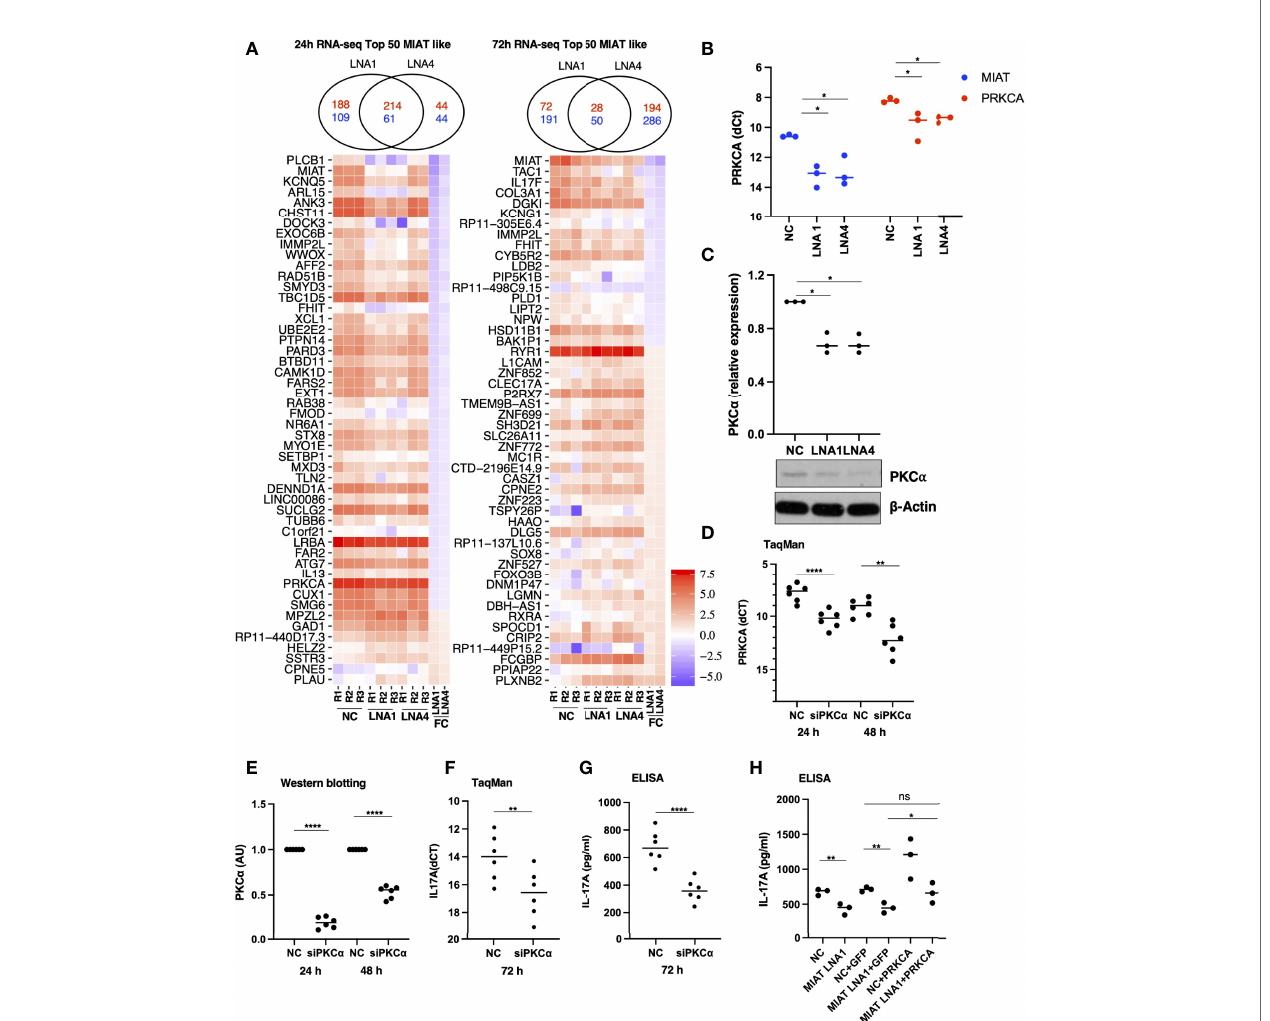
FIGURE 4 | RNA-seq Analysis Identi fi ed MIAT Targets in Human Th17 Cells. (A) Venn diagrams on the top show the overlap of the number of differentially regulated genes (FDR <0.05 and LFC >1.5) when comparing LNA1- or LNA4-transfected samples to the negative control LNA (NC). The numbers in red indicate common and unique upregulated genes, and numbers in blue indicate common and unique downregulated genes upon MIAT silencing. Heatmap representation of the expression of the top 50 DE genes similarly regulated (see results section for details) upon MIAT silencing at 24 (left) and 72 h (right) in Th17 cells. NC, LNA1 and LNA4 columns represent the gene expression (RPKM) in respective samples. FC columns represent the fold-change in gene expression upon MIAT silencing. (B) TaqMan qPCR of PRKCA expression analysis in MIAT silenced Th17 cells with two different LNAs at 24 h, where each dot represents an independent experiment. Students ’ paired two-tailed t-test was used to determine the signi fi cance. *, p <0.05. (C) Western blot expression analysis of PKC a proteins in MIAT-silenced 24-h Th17 cells. A representative result (lower panel) from three independent experiments for PKC a is shown along with b -actin for loading control. WB quanti fi cation was performed using ImageJ, from three independent experiments (upper panel), and signi fi cance was calculated using Students ’ t-test (two-tailed, paired). *, p <0.01. The data were plotted as arbitrary units (AU). (A-C) The experiments were performed on three pools of CD4 + T cells, where each pool contained cells puri fi ed from umbilical cord blood collected from 3-5 individuals. (D) TaqMan qPCR of PRKCA expression analysis showing knockdown ef fi ciency of the siRNA at RNA level at 24 h and 72 h. Students ’ paired two-tailed t-test was used to determine the signi fi cance. **, p <0.01; ****, p <0.0001. (E) Western blot expression analysis of PKC a proteins showing knockdown ef fi ciency of the siRNA at protein level at 24 h and 72 h The quanti fi cation was performed using ImageJ, from three independent experiments, each having two biological replicates. The intensities were normalized to b -actin. The signi fi cance was calculated using Students ’ t-test (two-tailed, paired). ****, p <0.0001. The data were plotted as arbitrary units (AU). (F) TaqMan qPCR of IL17A expression from three independent experiments, each having two biological replicates. The Ct values were normalized to EF1A. The signi fi cance was calculated using Students ’ t-test (two-tailed, paired). **, p <0.01. (G) IL-17A secretion as measured by ELISA. The data was obtained from three independent experiments, each having two biological replicates. The data has been normalized to number of cells in the culture-well. The signi fi cance was calculated using Students ’ t-test (two-tailed, unpaired). ****, p <0.0001. (D-G) The experiments were performed on six pools of CD4 + T cells, where each pool contained cells puri fi ed from umbilical cord blood collected from 3-5 individuals. (H) IL-17A secretion as measured by ELISA. The scheme for this experiment has been shown in Figure S7A . In the fi rst nucleofection cells were transfected with NC or MIAT targeting LNA, whereas in the second nucleofection the cells were either mock transfected or they were transfected with in vitro transcribed GFP or PRKCA RNA. The experiments were performed on three pools of CD4 + T cells, where each pool contained cells puri fi ed from umbilical cord blood collected from 3-5 individuals. The signi fi cance was calculated using Students ’ t-test (two-tailed, paired). **, p <0.01; *, p <0.05; ns denotes not signi fi